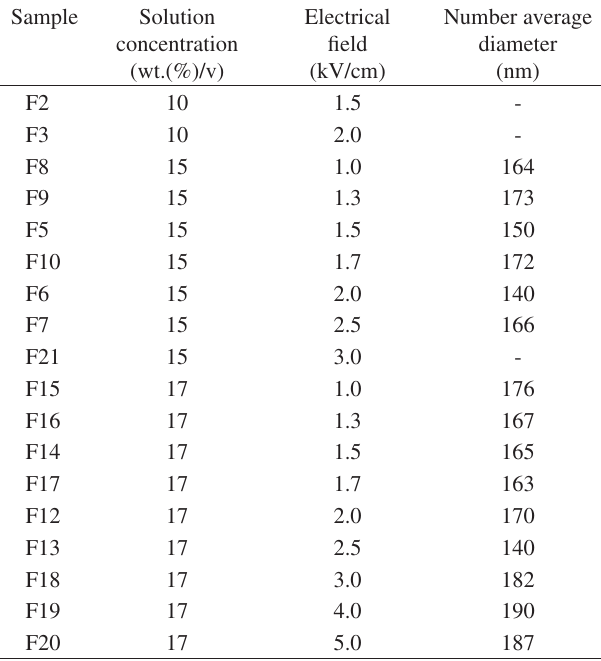
Table 6. Properties of the polyamide 66.